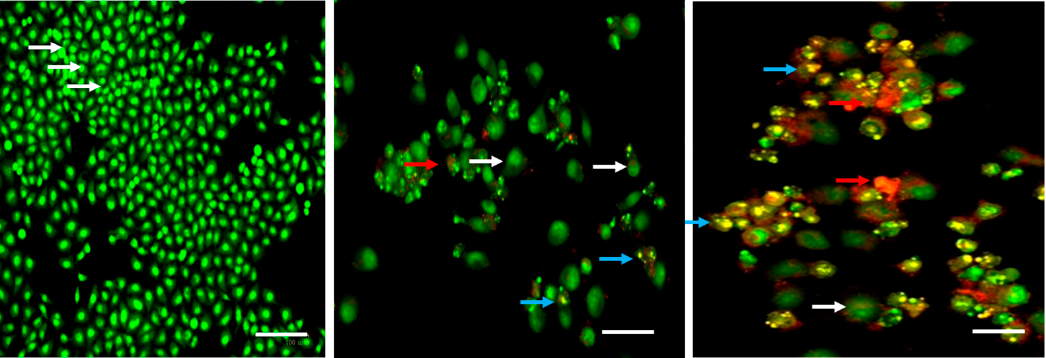
Figure 4. Effect of albumin visnagin NPs on apoptosis in MDA-MB-468 cells for 24 h. The cells were stained with ethidium bromide and acridine orange (1:1) and assessed using fluorescence microscopy (Labomed, Los Angeles, CA, USA). As shown by the white arrow, the control cells exhibited green fluorescence (indicating viable cells). As shown by the blue arrow, albumin visnagin NPs-treated cells revealed yellow/orange fluorescence, indicating early and late apoptosis, respectively. Necrosis is indicated by the red arrow. Control (untreated cells) ( Left ), albumin and visnagin NPs-treated cells; IC25 ( Middle ) and IC50 concentrations ( Right ). This is a representative image of the experiment performed in triplicate with 20X magni fi cation (scale bar = 100 mm).